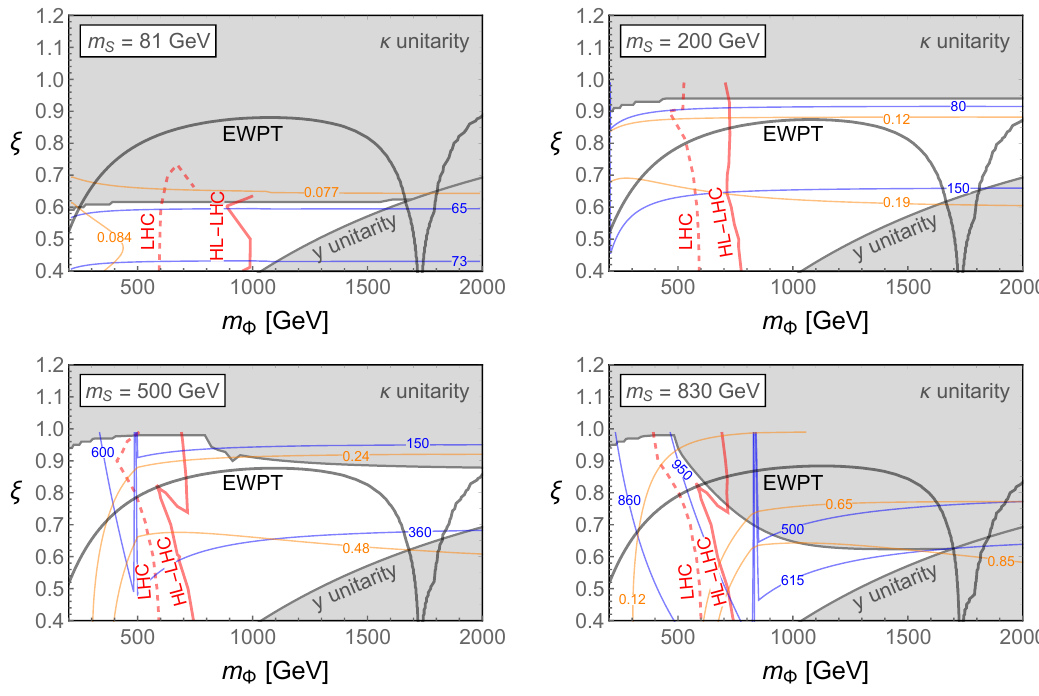
Figure 11 . Constraints on the parameter space of the scalar UV completion for the singlet scalar model. Note that m The S , m Φ are now mass parameters in L III (eq. (C.1)), not mass eigenvalues. parameter ξ = κv/m controls the mixing between the singlet S and the scalar doublet mediator S m Φ Φ . At each point in this parameter space, the coupling y is chosen so that a BSM = ∆ a . The µ µ bottom-right region requires y couplings that violate unitarity. For large values of ξ , the trilinear coupling κ violates perturbative unitarity. The region below the black solid line is excluded by EWPT as described in the text. The regions to the left of the dashed (solid) red lines would be excluded by a conservative search in the 3+4 µ channels at the (HL-)LHC, see text. The blue (orange) contours represent the mass of the ϕ eigenstate that is mostly the singlet S (the coupling of this eigenstate 1 to muons), corresponding to the parameters m ( g ) in the singlet scalar effective theory S S